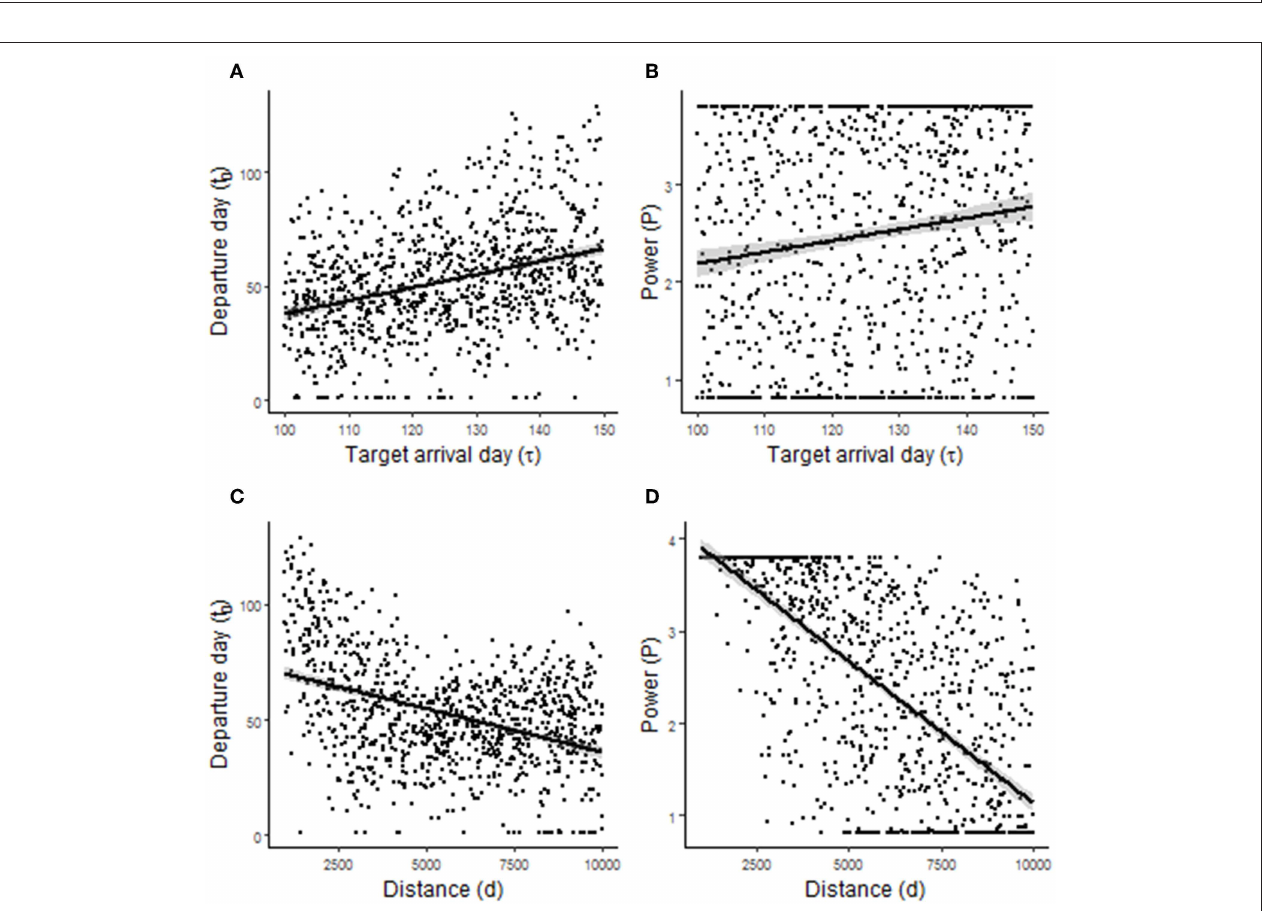
FIGURE 5 | Predictions arising from randomized simulations of migration model 2.1. (A,B) Show the effect of target arrival time τ on departure day of year t 0 and the power requirement for flight P (in W), respectively. (C,D) Show the effect of migration distance d on t 0 and P , respectively.